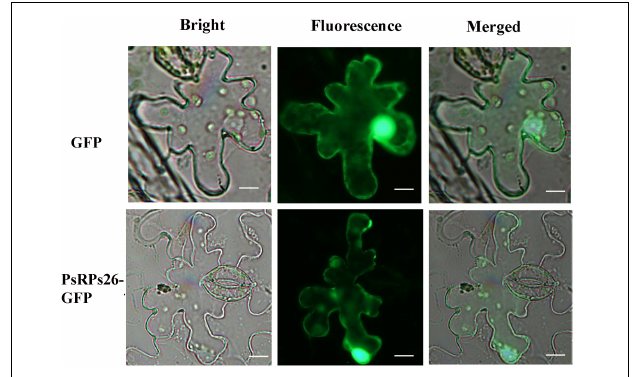
FIGURE 2 | Subcellular localization of the PsRPs26 protein. The PsRPs26-GFP fusion protein and GFP (control) were transiently expressed in Nicotiana benthamiana . Bar = 20 µ m. Similar results were obtained from three biological replicates.